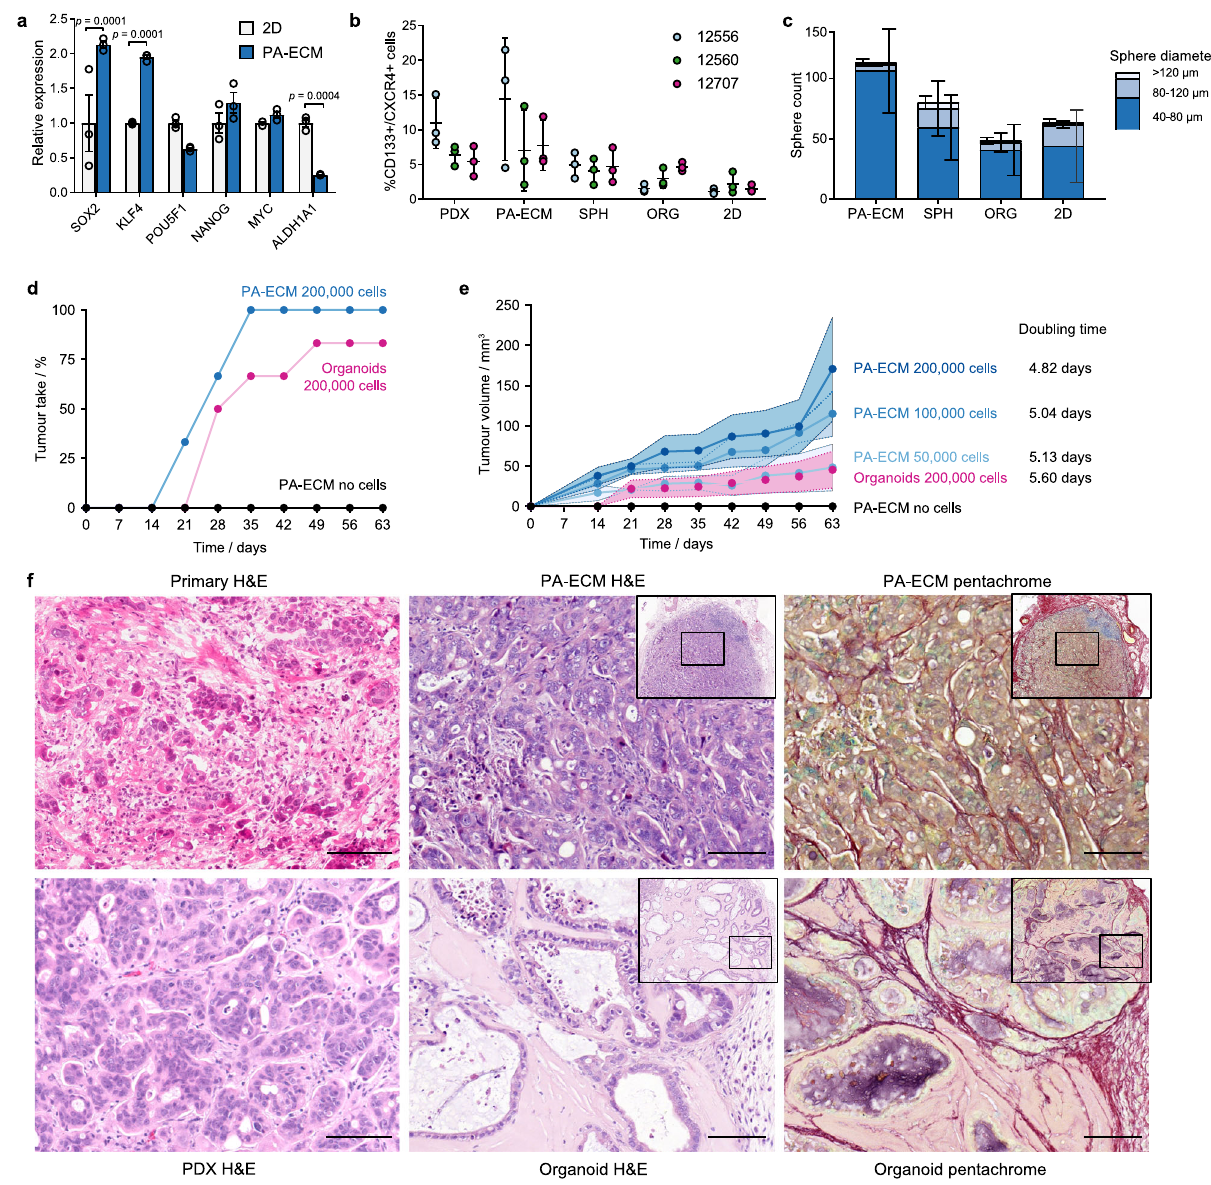
Fig. 4 CSC enrichment in PA-ECM cultures. a Expression of CSC factors by PDAC cells (12560) cultured in PA-ECM compared to 2D monolayers (mean ± SD; n = 3 biological replicates). b Percentage of CD133 + /CXCR4 + PDAC cells in PDX and ex vivo PDAC models as assayed by fl ow cytometry in three matched experiments (mean ± SD). c Number of spheres by size range formed by PDAC cells (12560) derived from PA-ECM cultures, primary spheres, organoids and 2D monolayers (mean ± SD; n = 3 biological replicates). d Engraftment rate of PA-ECM and organoid PDAC cultures (12560) implanted in nude mice (three mice with two tumours per condition). e Volume of tumours grown in nude mice from implanted PA-ECM and organoid cultures carrying increasing numbers of PDAC cells (12560) (three mice with two tumours per condition). Shaded areas denote standard deviation around mean. f Representative histology images of PDAC tissues derived from patient 12560, including primary tumour, patient-derived xenografts and tumours grown in nude mice from implanted PA-ECM and organoid cultures. Scale bars: 100 µ